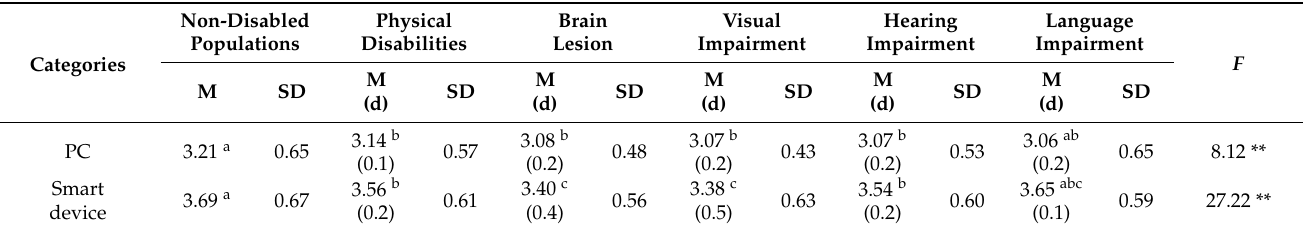
Table 2. COVID-19 effect on Internet usage changes on PC and smart